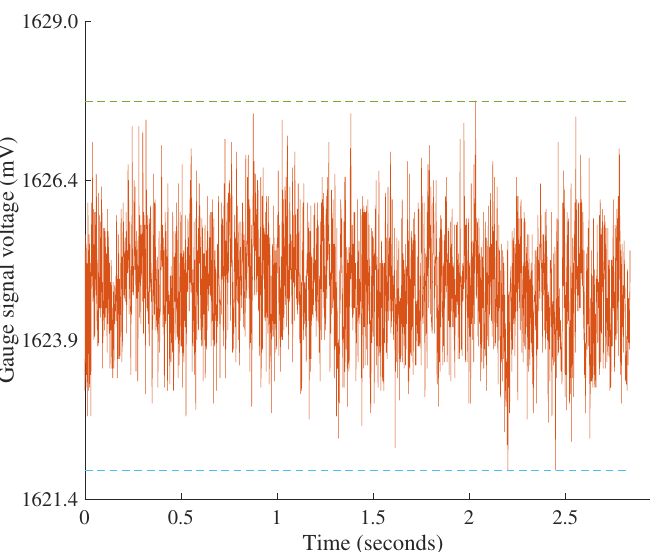
Figure 16. Voltage response of one voltage divider unit during constant 50% loading capacity. A fitted envelope has a green upper bound at the highest noise level and a blue lower bound at the lowest noise level. The height of the envelope represents the magnitude of noise in the signal, which here is 5.79mV. Note that the maximum noise of 3.8mV when calculated from X, Y, and Z signals is lower than noise calculated from raw divider signals due to how X, Y, and Z voltages are computed from raw